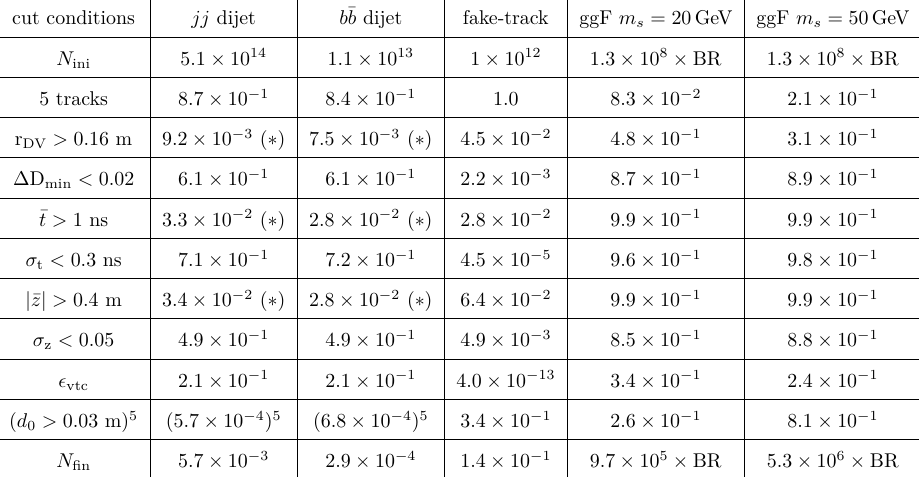
Table 5 . The cut-flow table for the QCD background, the fake-track background and the signal. N ini and N fin are the initial and final event numbers before and after imposing the cuts. These numbers correspond to an integrated luminosity of L = 3 ab − 1 at the HL-LHC. “5 tracks” requires each track has p T > 1 GeV and at least 5 tracks arrive at HGCAL. “ (cid:15) vtc ” is the total efficiency for the vertexing-cuts except those with ( ∗ ) . The efficiency of the d 0 cuts is calculated after applying the vertexing-cuts . We used the two signal benchmarks with m X = 20 and 50 GeV, and lifetime cτ X = 1